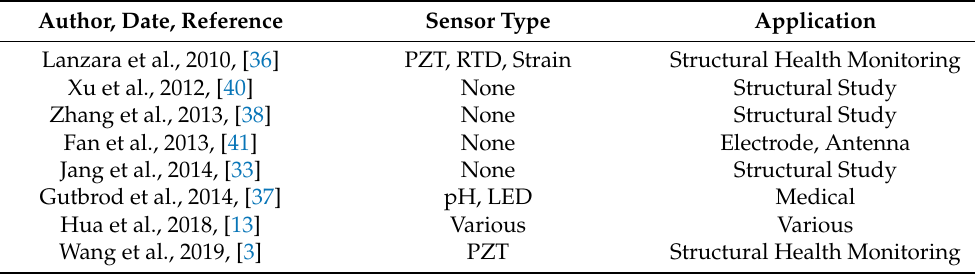
Table 1. Summary of the expandable sensor network literature (sensor types and applications).